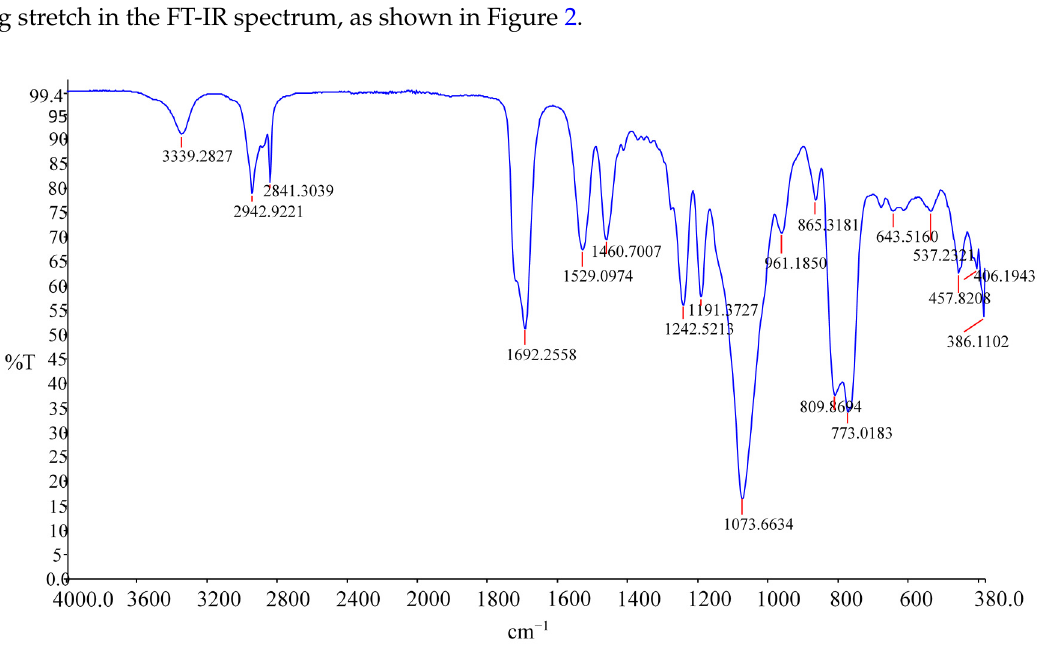
Figure 2. FT ‐ IR spectrum of silane terminated diethylene glycol. Figure 2. FT-IR spectrum of silane terminated diethylene